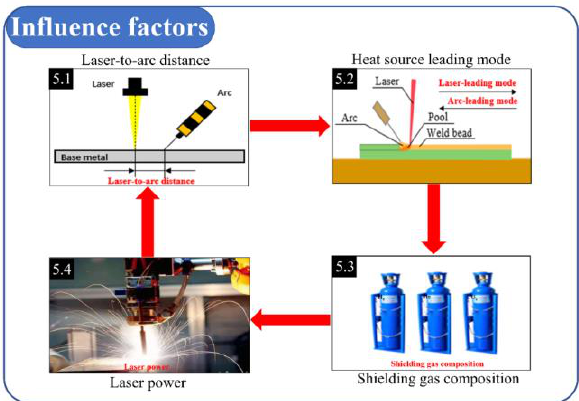
Figure 8. The main factors affecting droplet transfer.